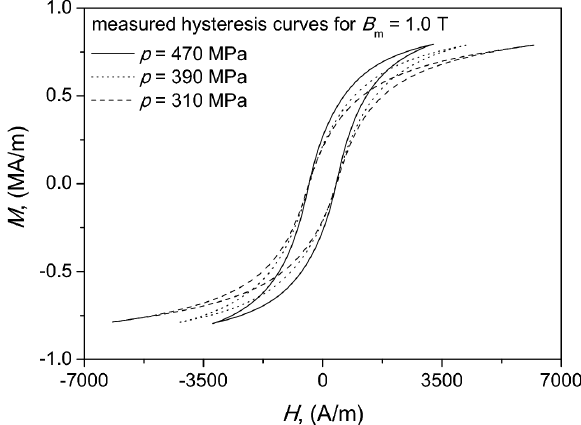
Figure 3. Measured hysteresis curves for chosen values of compaction pressure.